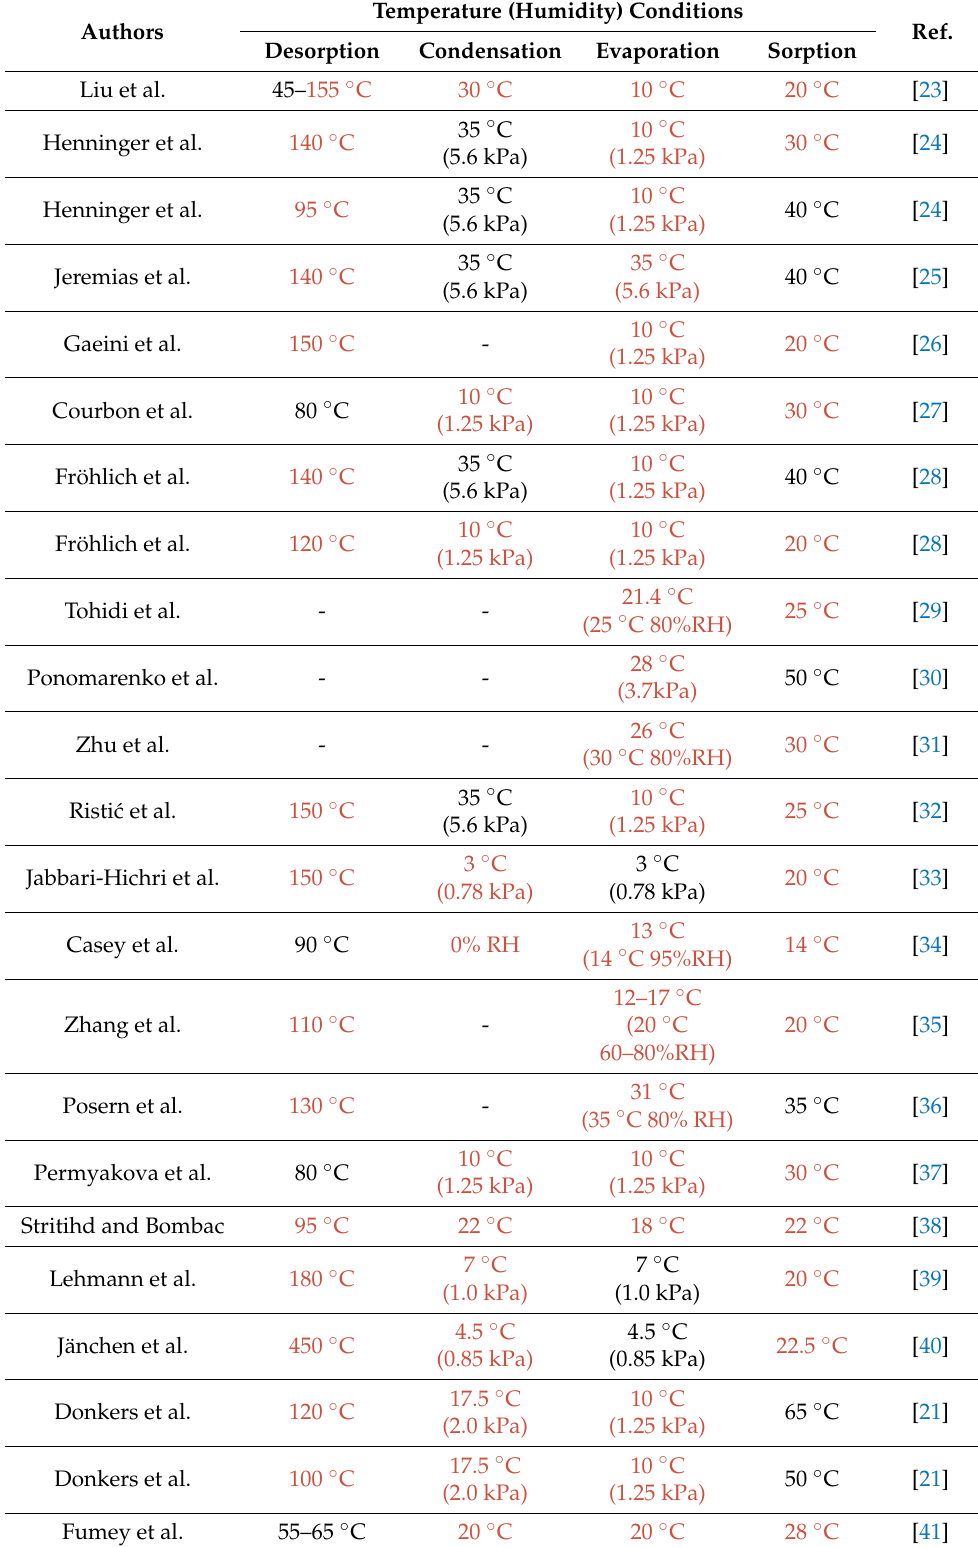
Table 1. List of testing temperatures from research papers. Red values are out of bound with reference to the proposed testing temperatures in Table